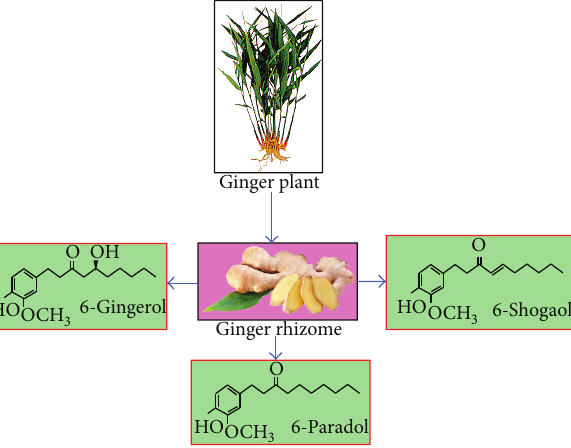
Figure 2: Ginger, ginger rhizome, and its major active components: 6-gingerol, 6-shogaol, and